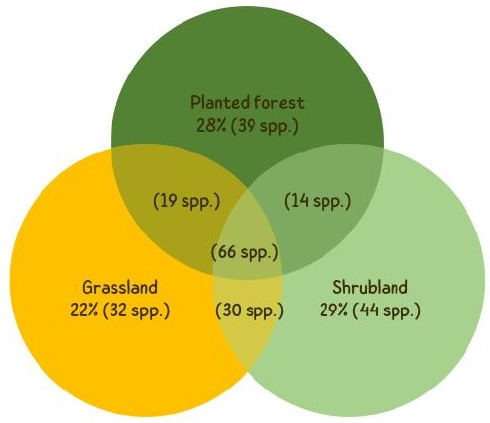
Figure 5. Shared vs. unique bee species in the three uncultivated habitats. The unique species are of the total number of species per habitat type (n = 9 for the shrubland and planted forest, n = 12 for the grassland).